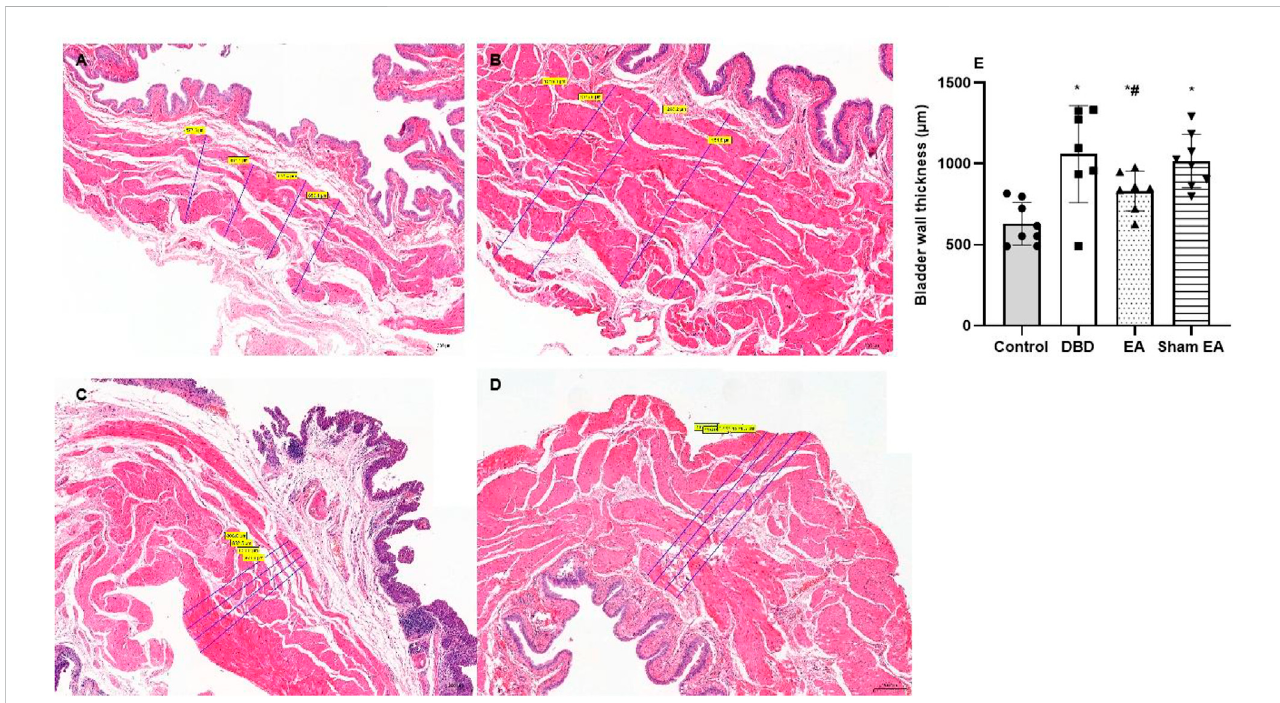
FIGURE 5 The bladderwall thickness ineach groupon HE images.Representative micrographs ofathinsection ofthebladderwall (magni fi cation ×50). Bargraphs show thequantitative imageanalysis. (A) .Controlgroup: n=8rats; (B) .DBDgroup: n = 7rats; (C) .EAgroup: n =7rats; (D) . Sham EAgroup: n = 8rats; (E) .The results of bladder wall thickness in the HE staining. Results are expressed as mean ± standard error of the mean. * p < 0.01 versus the Control group. # p < 0.01 versus the Sham EA group (one-way ANOVA).